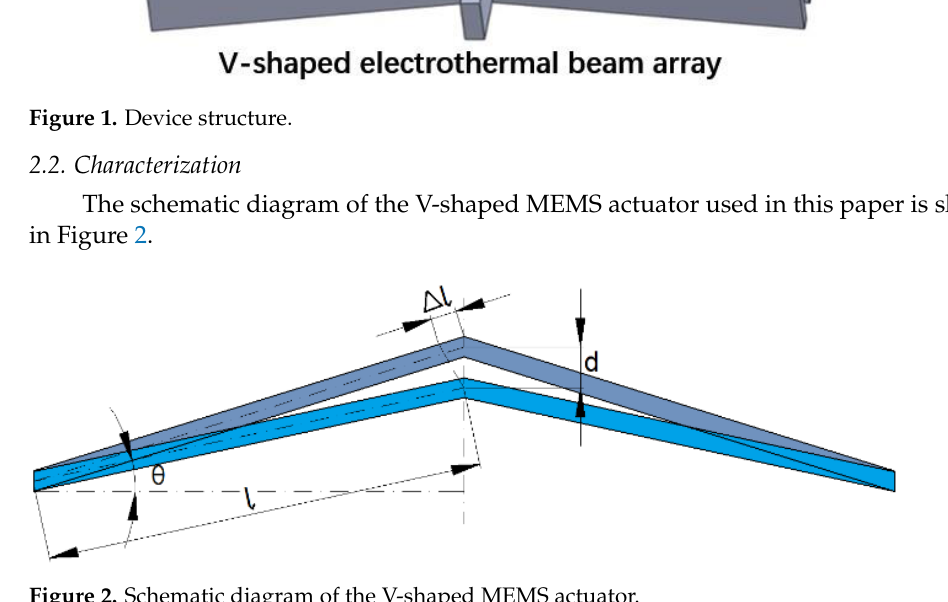
Figure 2. Schematic diagram of the V-shaped MEMS actuator. The main parameters required in theoretical calculation and simulation (main input and output parameters) are listed in Table 1. Table 1. Basic parameters of V-shaped electro-thermal actuator.